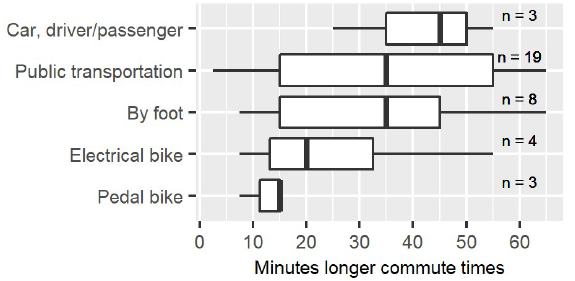
Figure 7. Willingness for longer commute times given new residence location due to telecommuting, grouped by stated primary transport